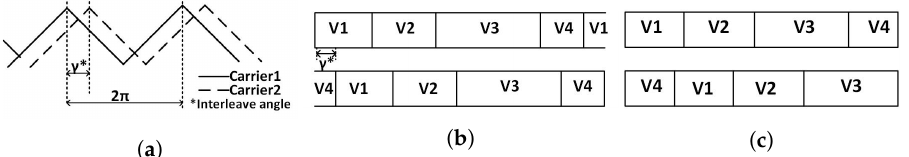
Figure 1. Idea of interleaving ( a ). In carrier-based PWM schemes ( b ). As time shift in space vector- based modulations ( c ). As sequence rearrangements in space vector-based